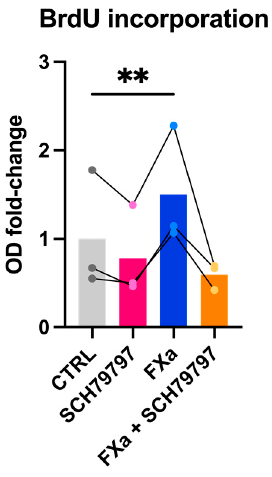
Figure 5. Effect of PARs silencing on CCL2 and IL6 expression ( A , B ; n = 6). Human atrial CFs were transfected with 10 µ M of either scrambled PAR-1 or PAR-2 specific siRNA before exposure to TRAP-14 (100 µ M). Gene expression was measured by RT-qPCR after 4 h of incubation. Data were normalized to the housekeeping gene Cyclophilin-A. Results are expressed as median bars, with dots indicating individual human CF isolations. Statistical analysis was performed using the non-parametric Friedman test ( CCL2 : overall p < 0.0001; IL6 : overall p < 0.0001) test for paired samples and Dunn’s multiple comparison test (* p < 0.05, ** p < 0.01, *** p < 0.001).